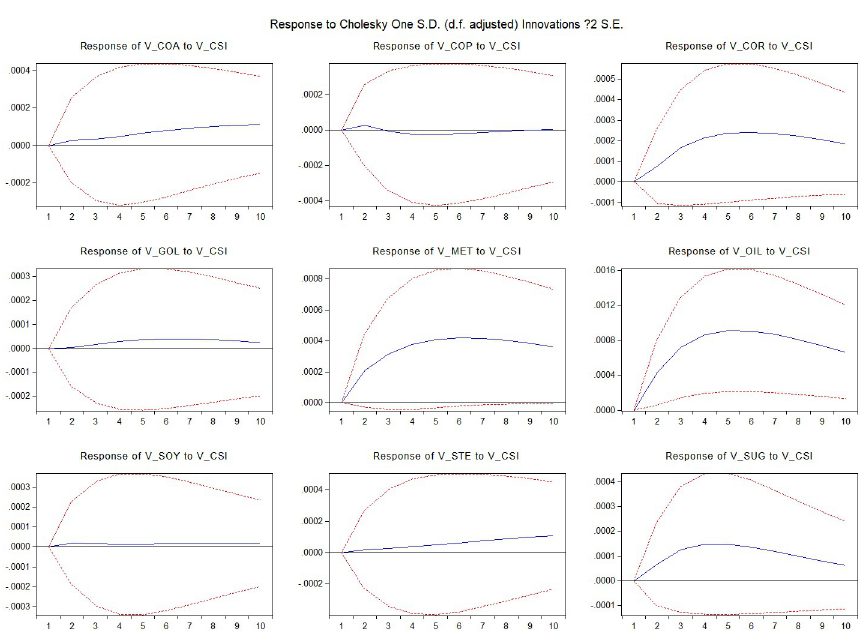
Fig 3. Impulse response functions of market i volatility to CSI300 index volatility. The figure presents the response of market i volatility (i = coa, cor, cop, gol, met, oil, soy, ste, sug) to CSI300 index volatility shocks. The sample runs from January 1, 2010 to March 22, 2021. The dotted lines are confidence bands based on Monte Carlo simulated standard errors.